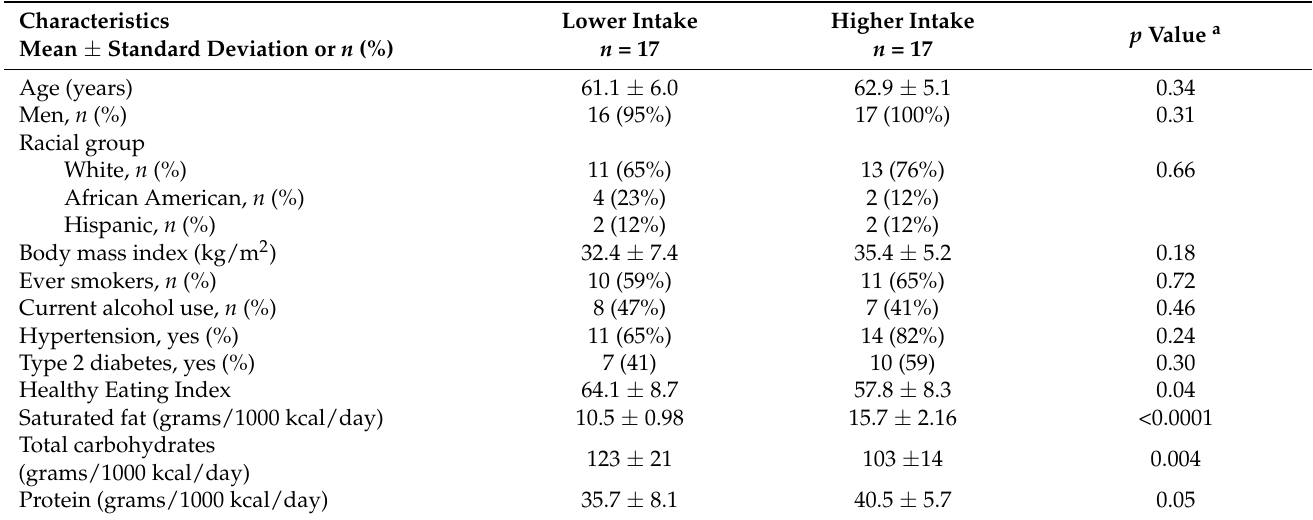
Table 1. Patient characteristics by higher vs. lower saturated fatty acid